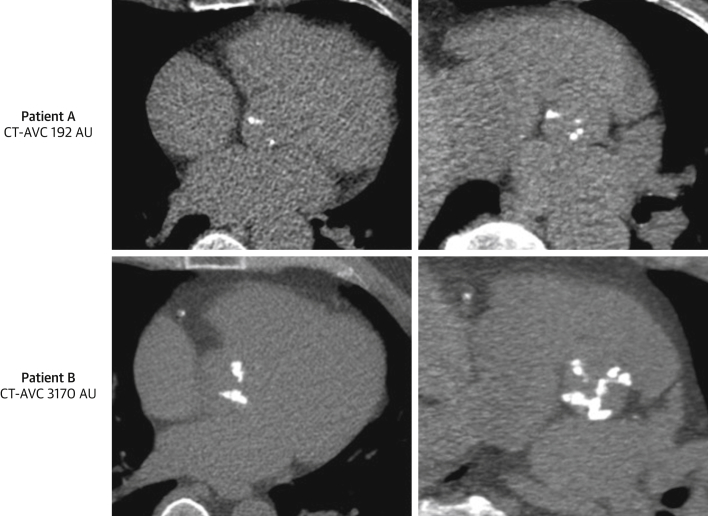
CT Calcium Scoring of the Aortic ValveAn example of mild aortic valve calcification (AVC) (Patient A, top) and severe calcification by computed tomography (CT) (Patient B, bottom) in axial (left) and short-axis (right) views of the valve. AU = arbitrary unit(s).